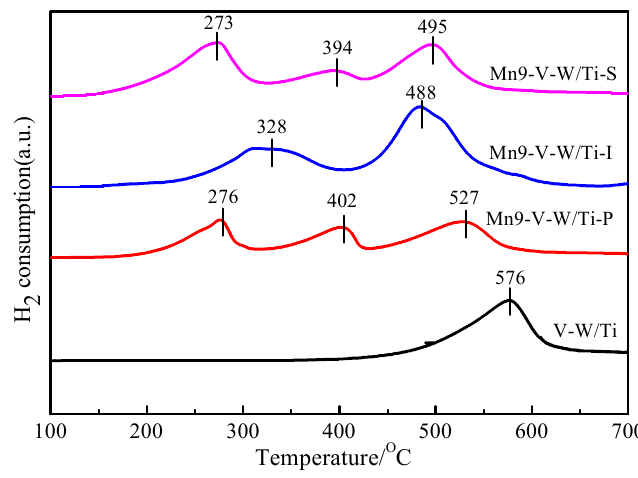
Figure 7. H 2 -temperature programmed reduction (TPR) profiles of the catalysts. Reaction conditions: purging the catalysts with N 2 at 110 °C; programmed temperature reduction with H 2 at 50 – 600 °C, the heating rate is 5 °C/min.